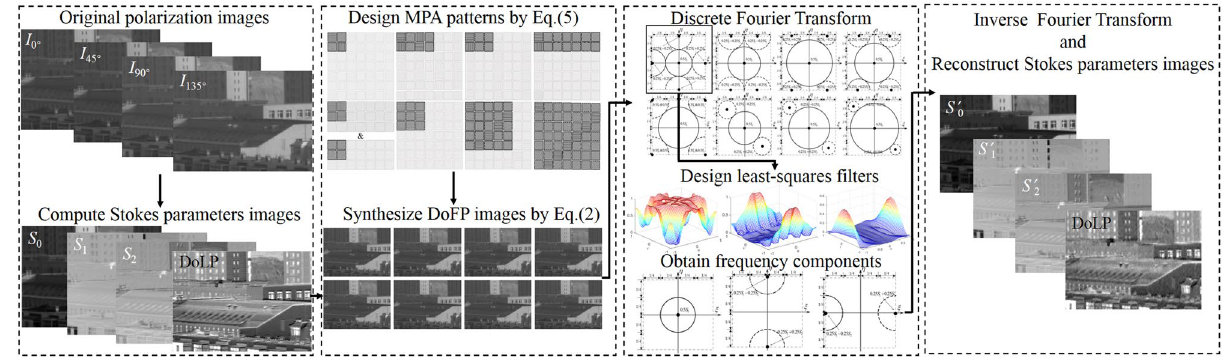
Figure 2. Flowchart for reconstructing the images of different Stokes